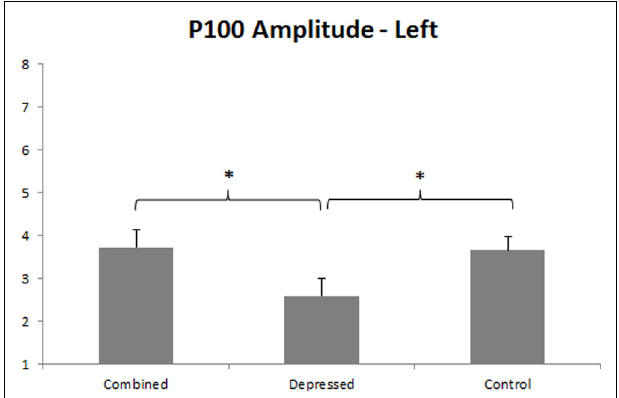
FIGURE 2 | P100 amplitude in left hemisphere. Error bars represent 1 SE. Asterisks indicate significant differences ( p < 0.05), with reduced P100 amplitude in the depressed compared to the combined group, and in the depressed compared to the control